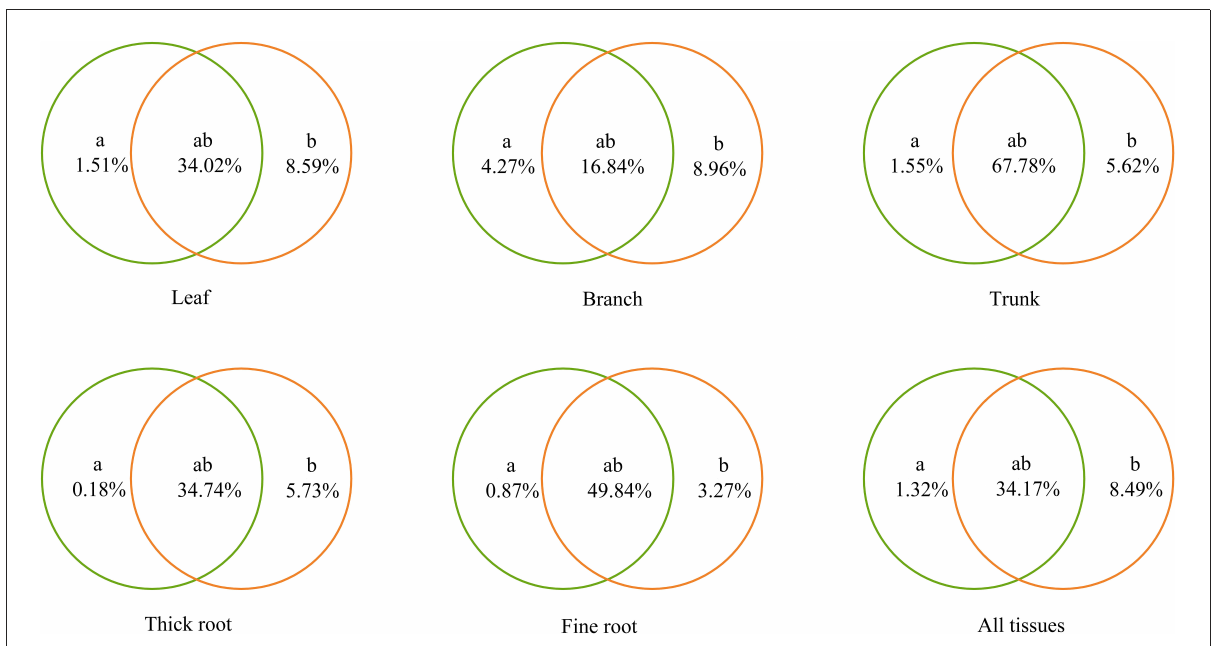
FIGURE6 Variance partitioning analysis of the relationships between the stoichiometry of Qinghai spruce and environmental factors. “a” and “b” indicate the independent effects of soil and climate, respectively; accordingly, “ab” indicates the interactive effects of soil and climate.